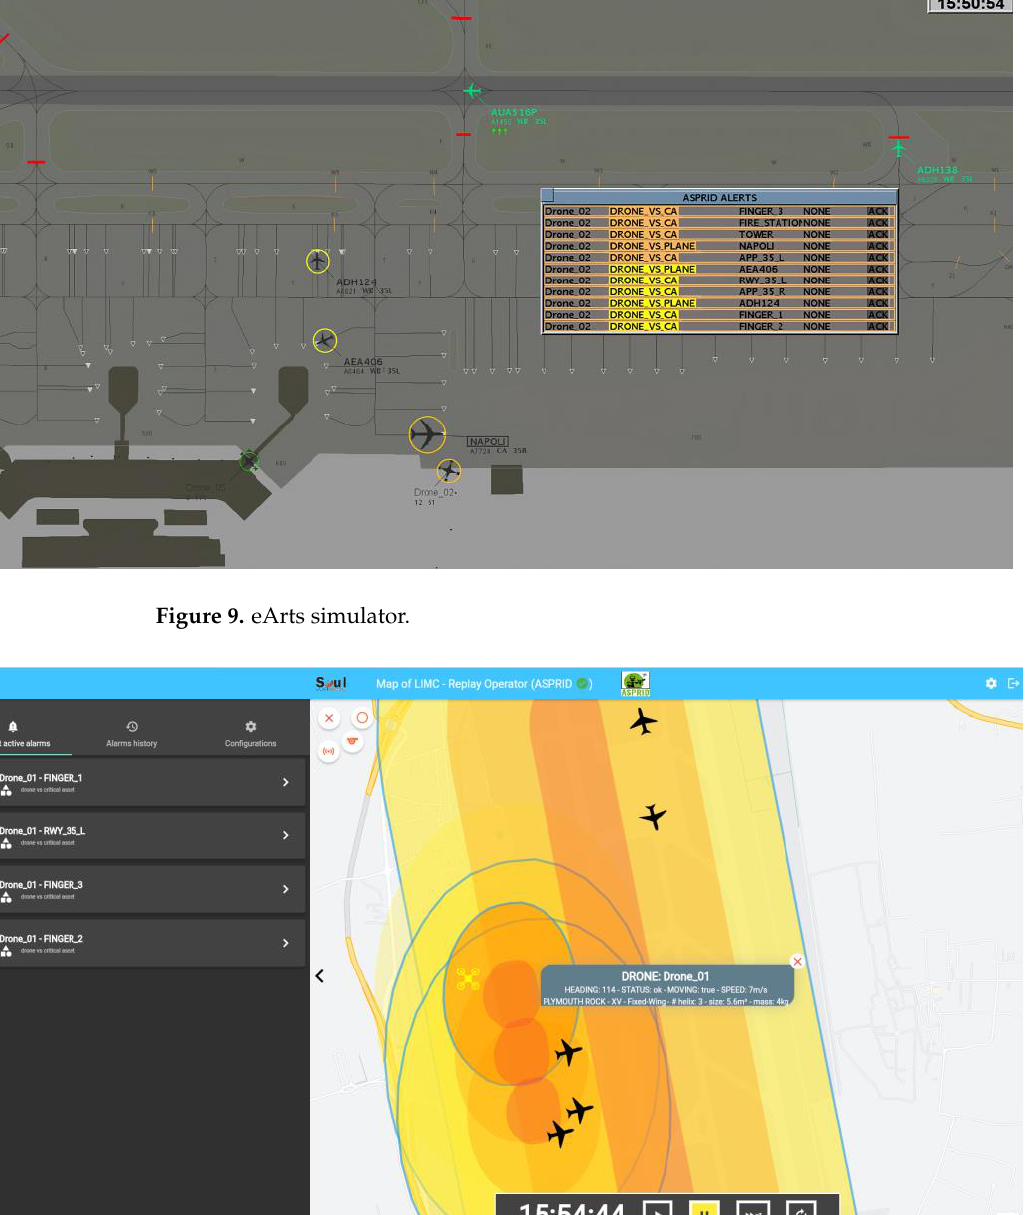
Figure 10. ASPRID web app.